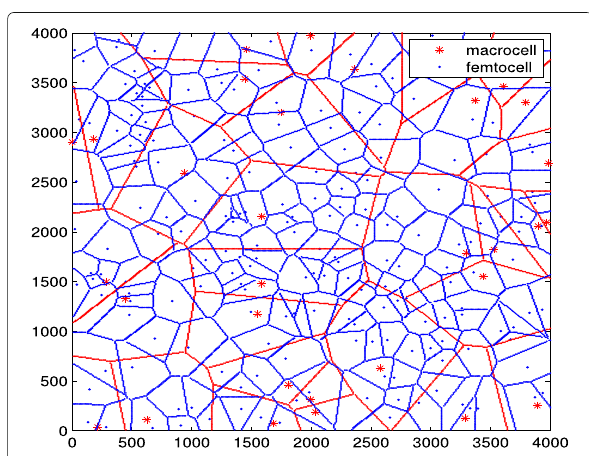
Fig. 2 The network is modeled as a superposition of two independent Voronoi